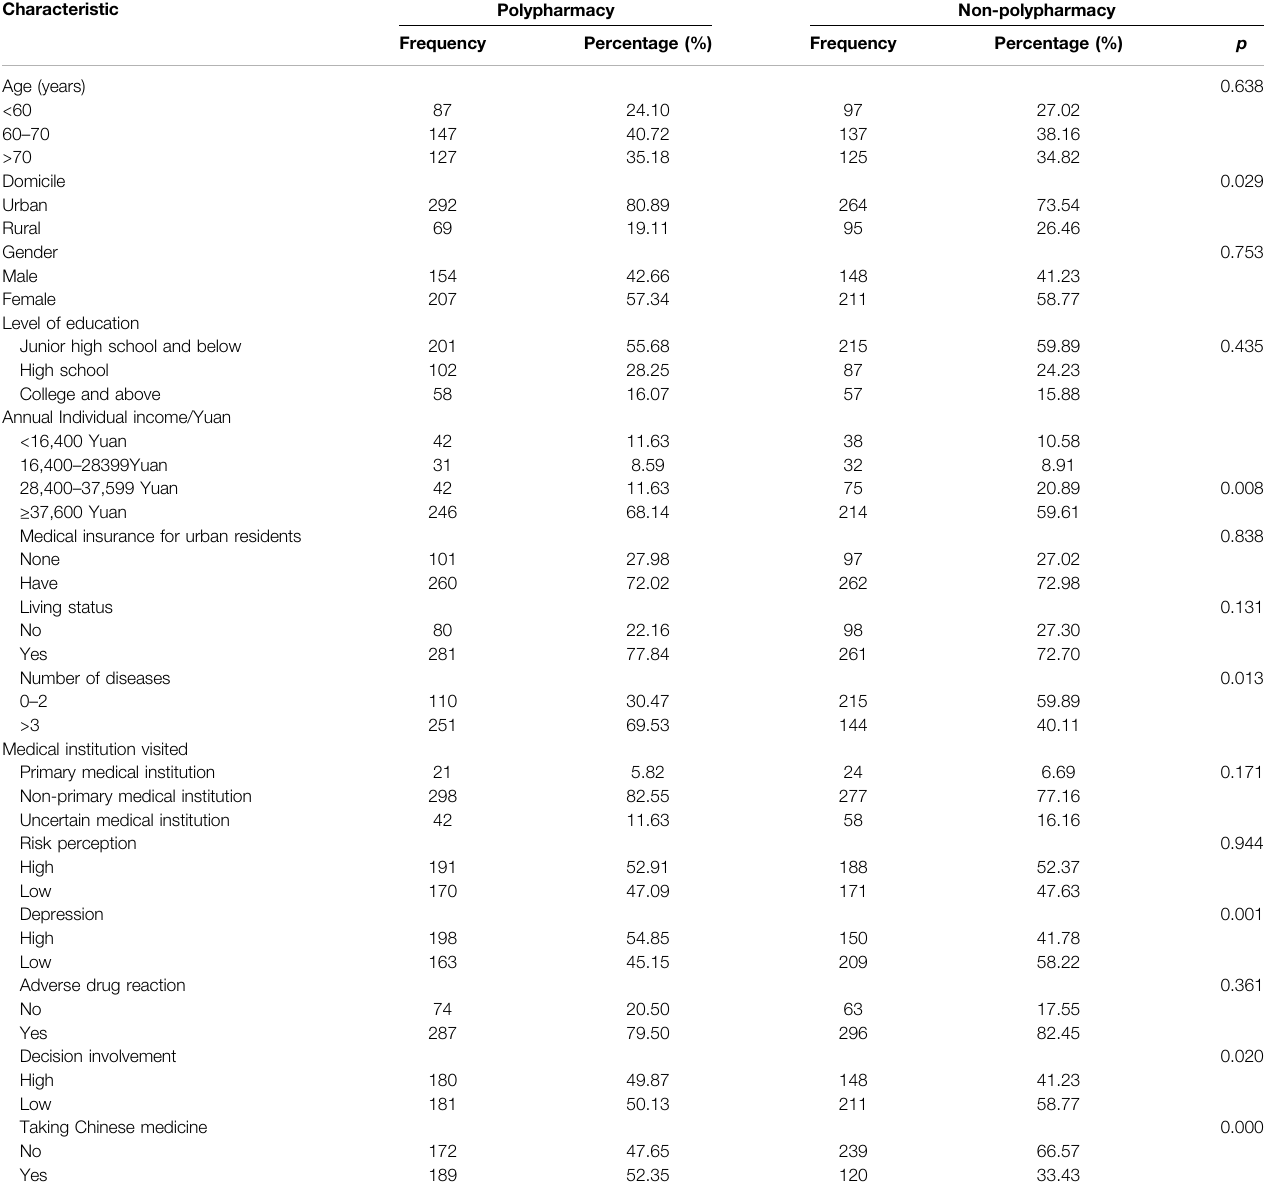
TABLE 3 | Characteristics of polypharmacy and non-polypharmacy among the